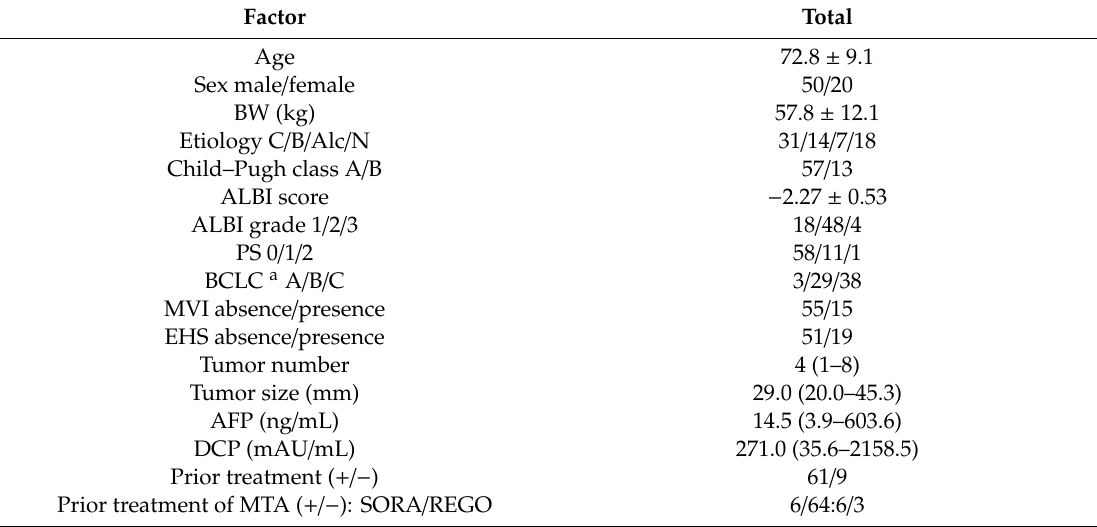
Table 1. Patient